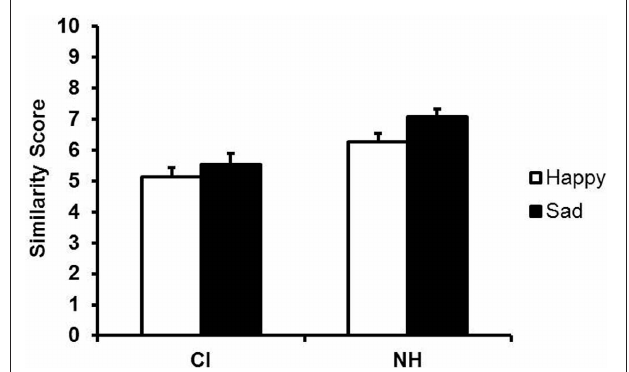
FIGURE 1 | Mean ratings of child CI users’ and NH children’s imitations of the model’s happy and sad utterances (content intact). Error bars indicate standard